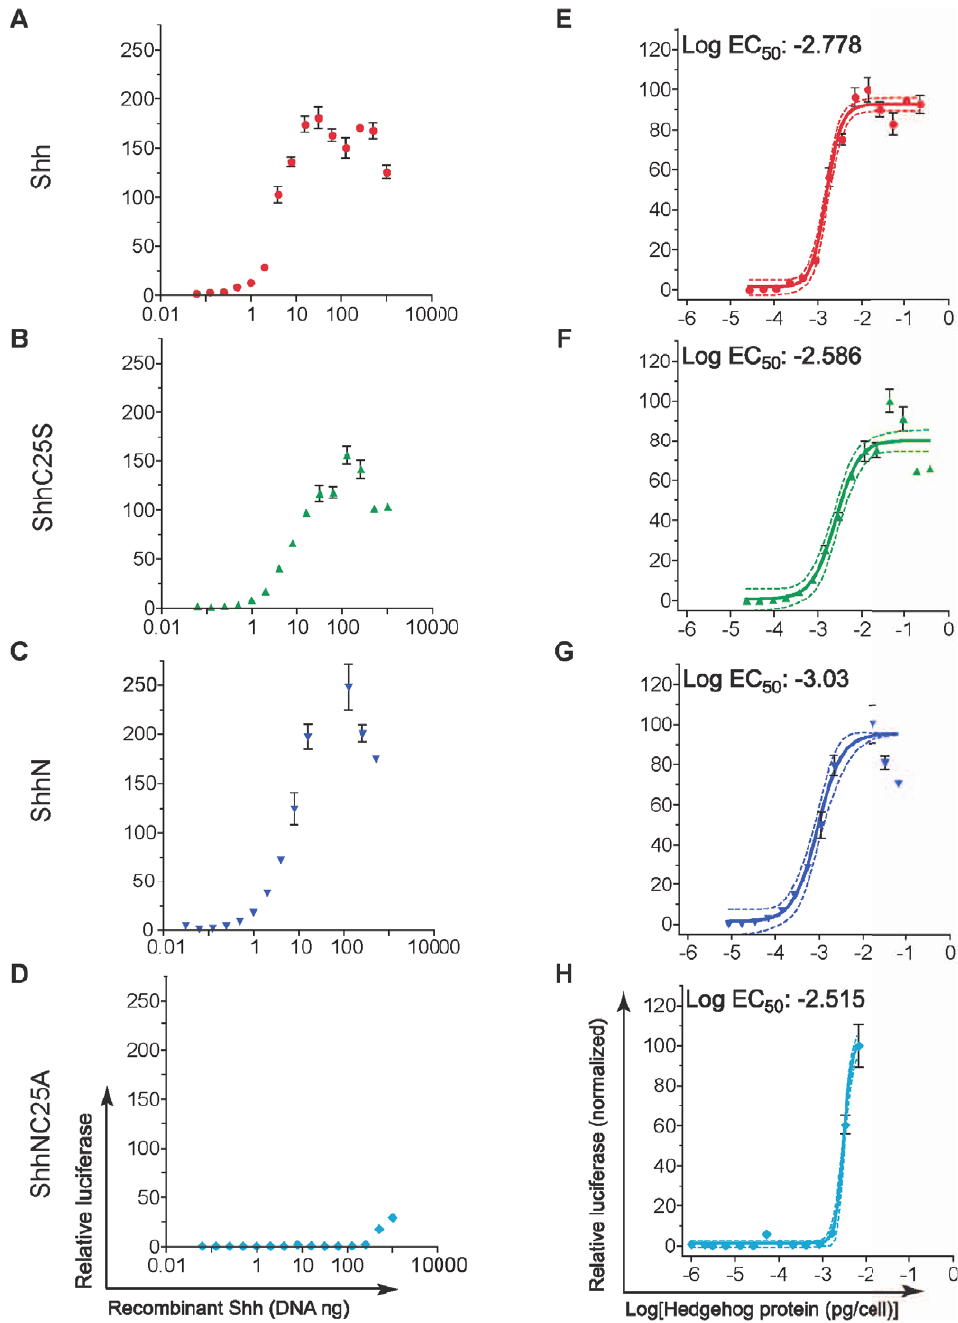
Figure 7. Shh signaling potency is directly related to cellular concentration of ligand. NIH3T3 fibroblasts were co-transfected with expression plasmids for recombinant Shh (Shh, ShhC25S, ShhN, or ShhNC25S), EGFP, Gli-reporter (8xGli-luciferase) and LacZ, changed to low-serum medium for 40 hours, and then analyzed for chemiluminescence. (A–D) Shown are relative luciferase values as a function of transfected recombinant Shh cDNA. ShhNC25A signaling was significantly reduced in comparison to Shh, ShhC25S, and ShhN. (E–H) Analysis of relative luciferase activity as a function of recombinant ligand expressed per transfected cell (pg/cell) revealed that all of recombinant forms of Shh signaled with equal potency. Solid line denotes non-linear regression and the dotted lines denote confidence intervals of 95%. Experiments were performed in replicates of